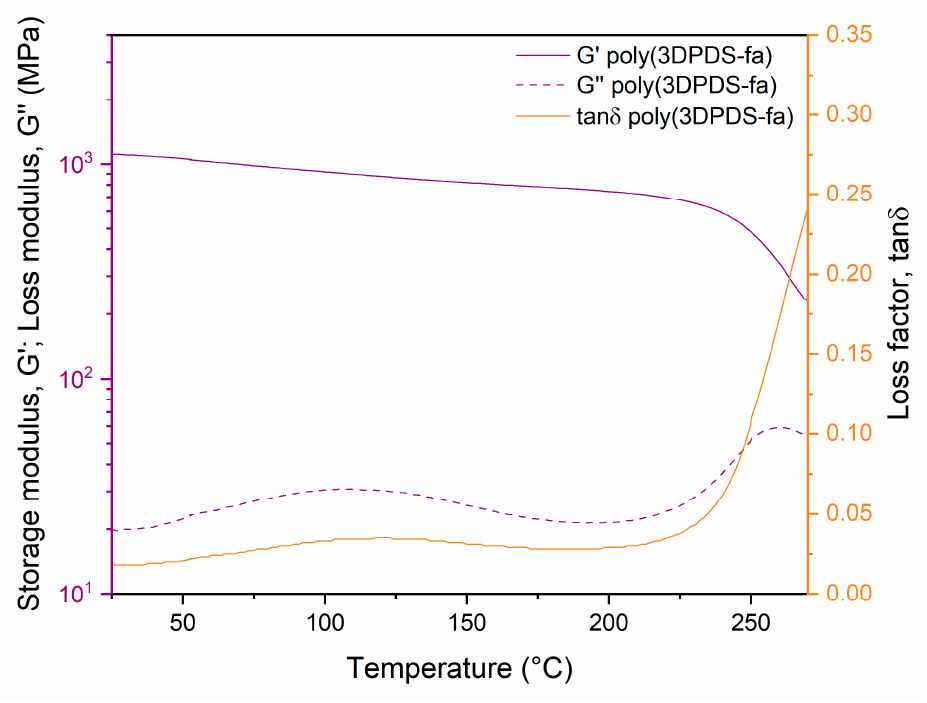
Figure A19. Rheology temperature sweep curves in torsion mode of poly(3DPDS-fa).